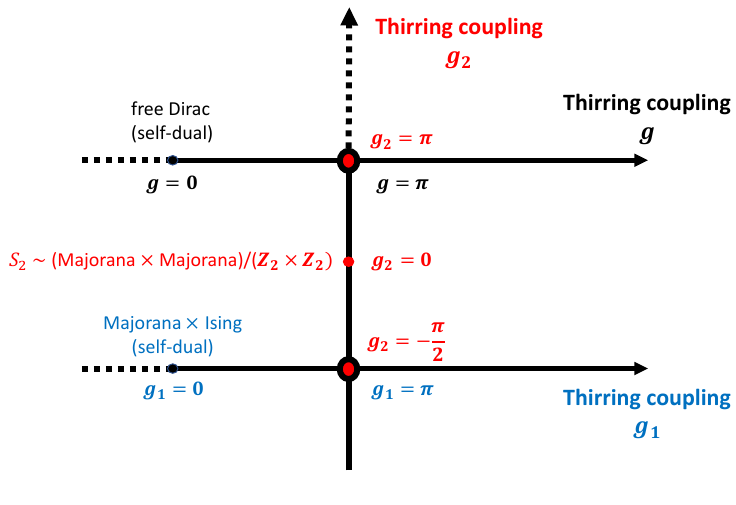
Figure 2: The moduli space of fermionic c = 1 CFTs connected to the free Dirac